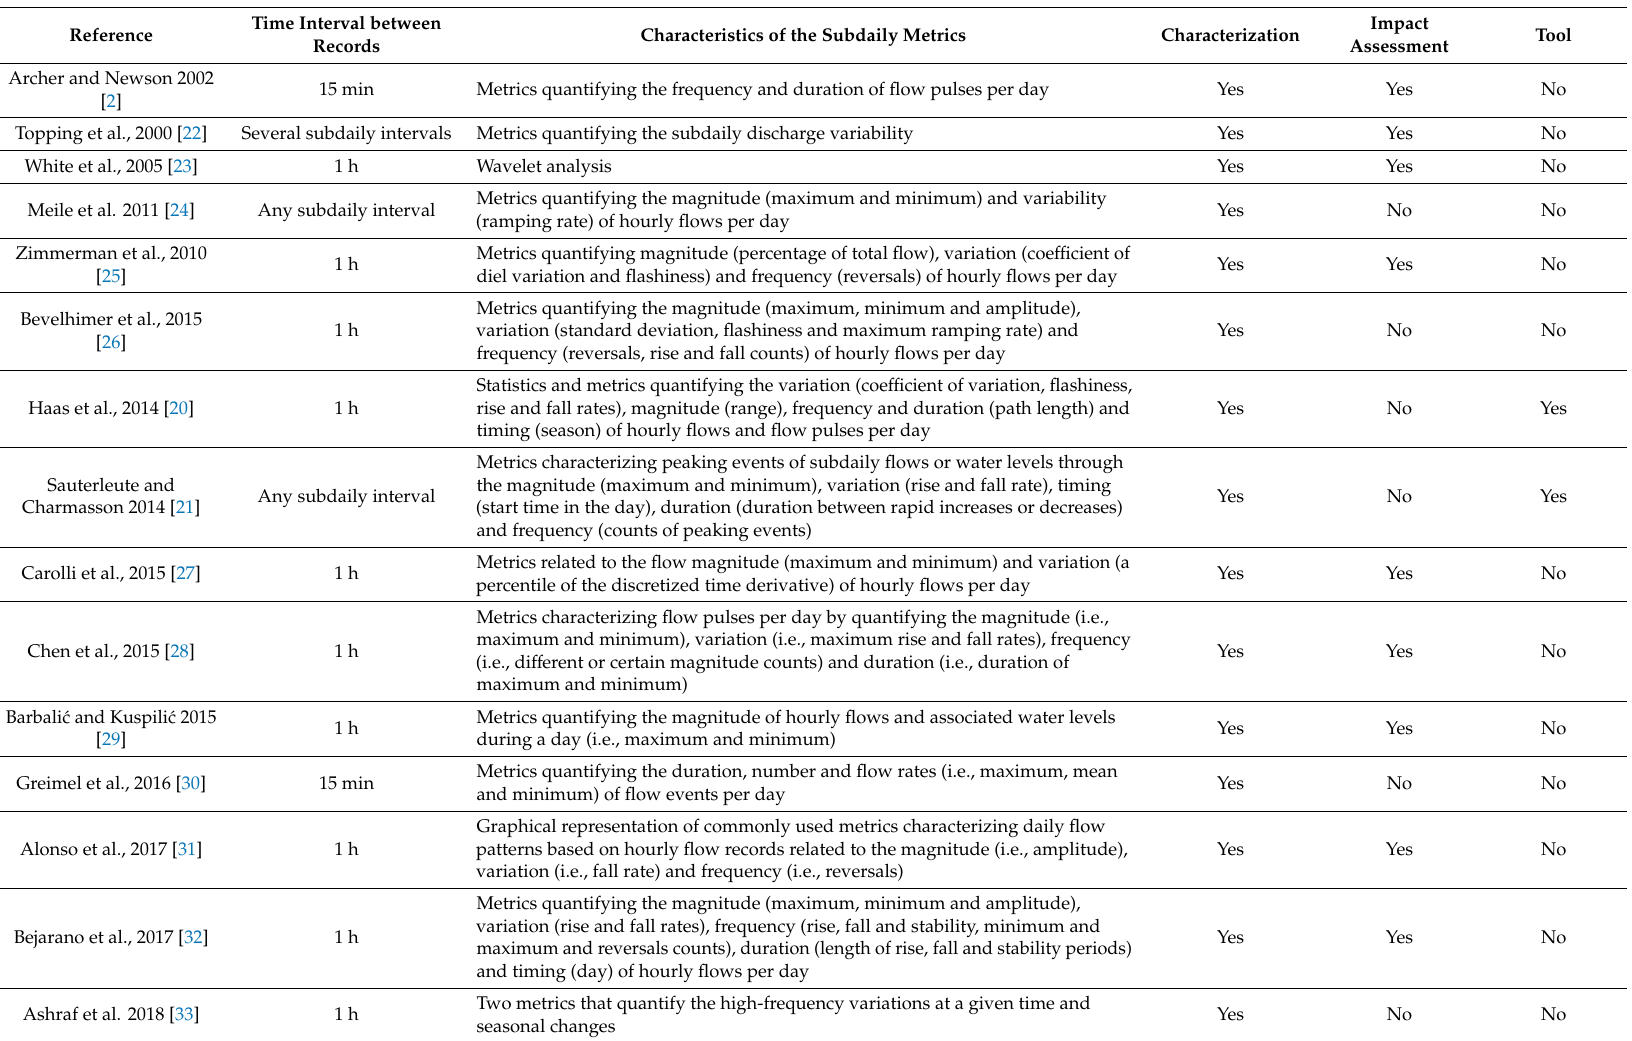
Table 1. Review of literature dealing with subdaily flows and water